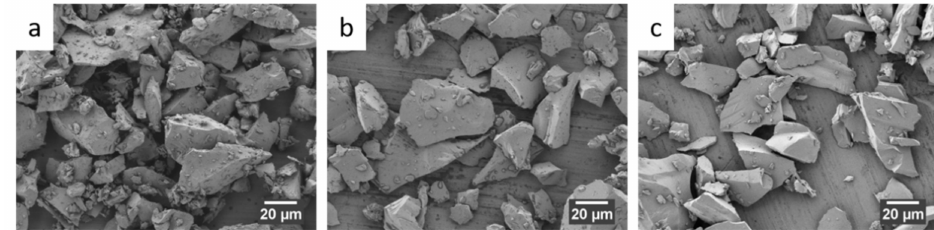
Figure 1. SEM pictures of the bioactive glass (BG) granules. ( a ) ICIE-16 BG, ( b ) 3Mg-BG and ( c )